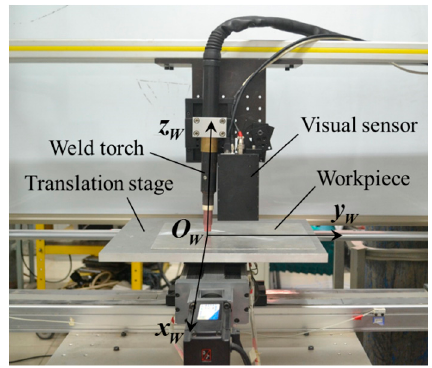
Figure 21. The established experiment platform for narrow butt detection.